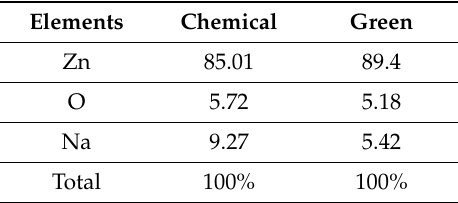
Figure 10. SEM micrograph of chemical and green synthesized ZnO NPs. Table 3. EDX spectra of chemical and green synthesized ZnO NPs to determine the elemental contents of typical points on the surface.